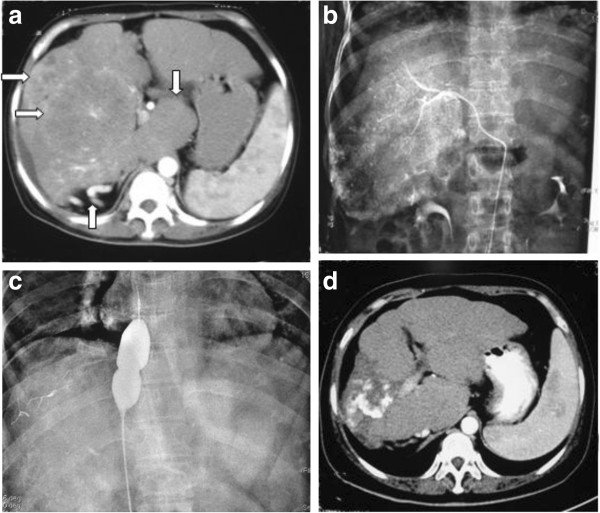
45-year-old woman with HCC in BCS. (a) Contrast-enhanced transverse CT scan showing two large heterogeneous enhanced nodules (⇨) in the right liver during arterial phase and enlarged caudate lobe (⇩), ventral varicosities (⇧), liver cirrhosis and mild ascites. (b) The two nodules were given TACE. (c) The blocked inferior vena cava was given angioplasty. (d) CT scan showing that the nodules were obviously shrinked and obtained stable effect after 4 TACE and 1 angioplasty during the 22-month treatment. Lipiodol was not located equably in the nodules.